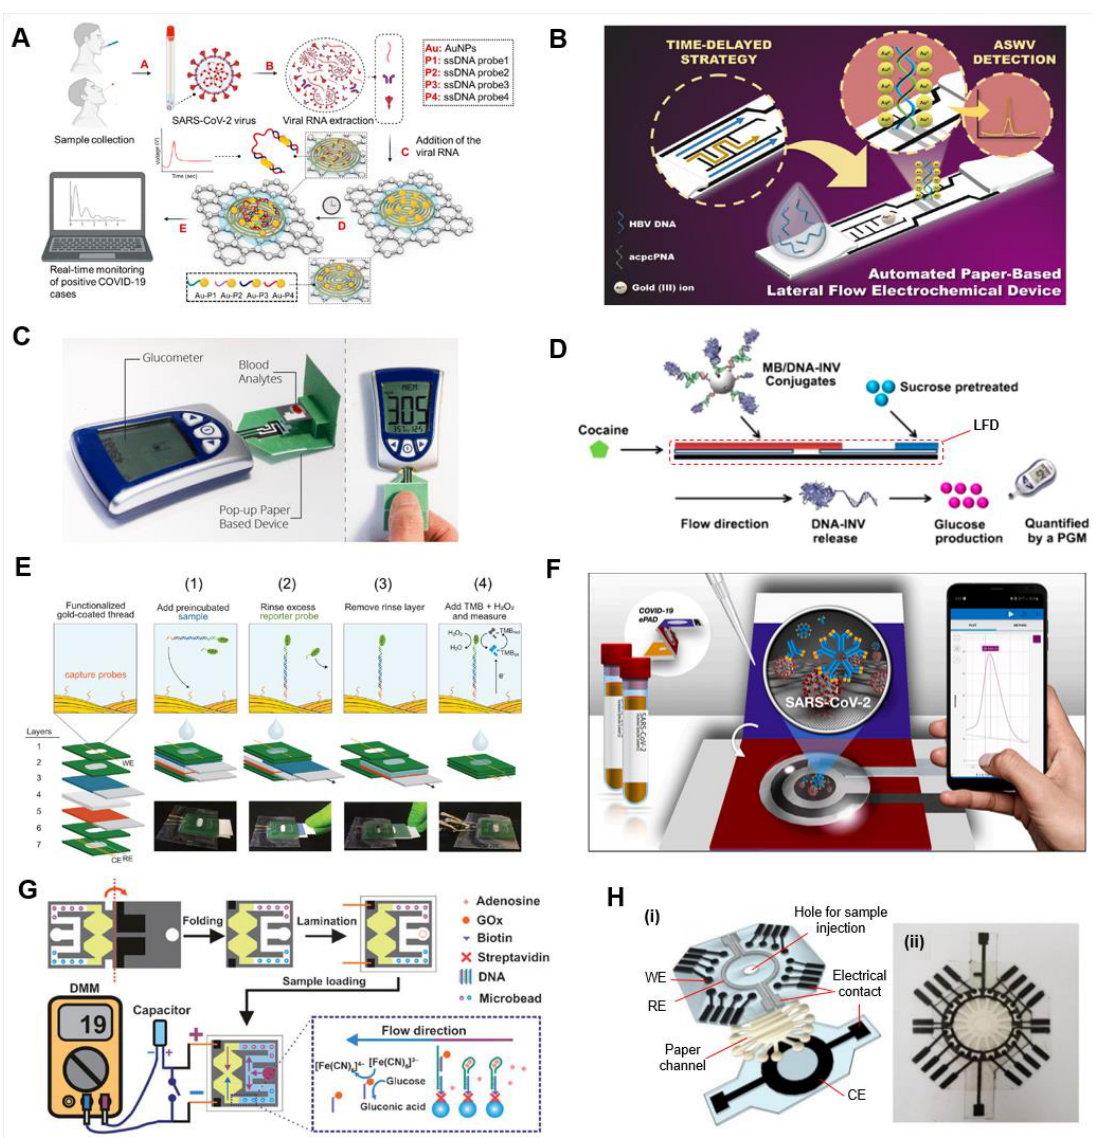
Figure 5. Paper-based potential electrochemical assays. ( A ) Schematic illustration of the paper- based electrochemical immunosensing platform for amplification-free SARS-CoV-2 RNA detection in nasal swab or saliva samples. Adapted with permission from [121]. Copyright 2020, American